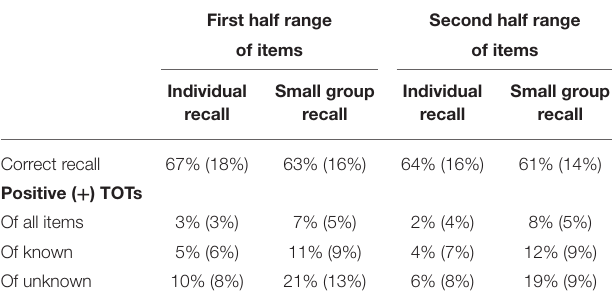
TABLE 8 | Mean (standard deviation) percentages of correctly recalled items and positive TOT indexes by experimental condition for the first and second half range of